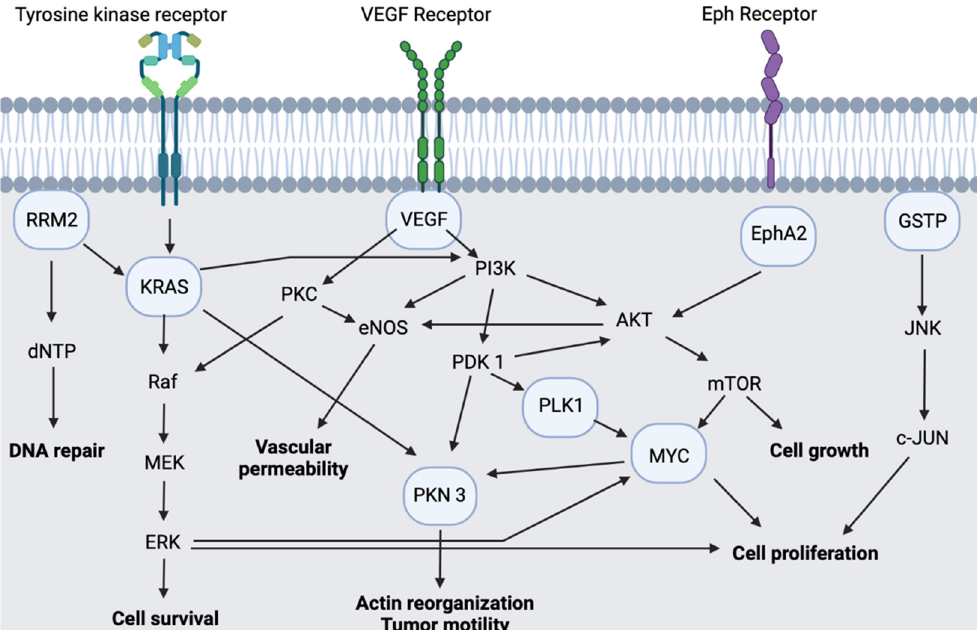
Figure 5. Simplified signaling cascade of selected genes for cancer therapy in clinical trials. Created with BioRender.com.